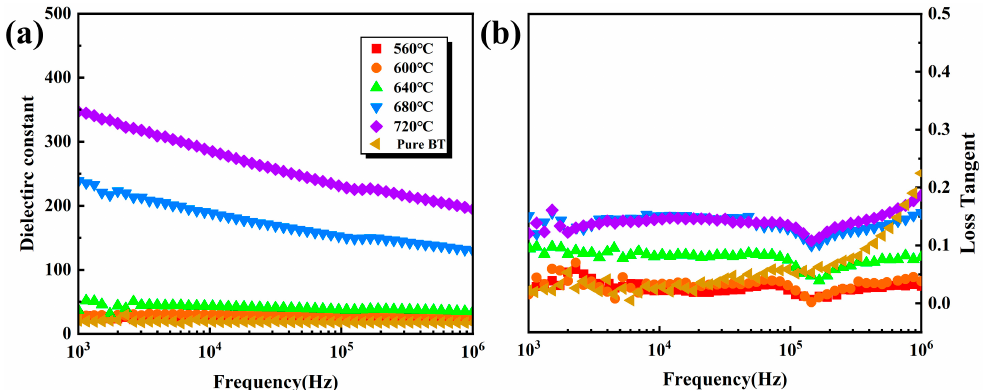
Figure 5. Image of BT-8% Mn films dielectric properties with frequency: ( a ) dielectric constant; ( b ) dielectric loss.